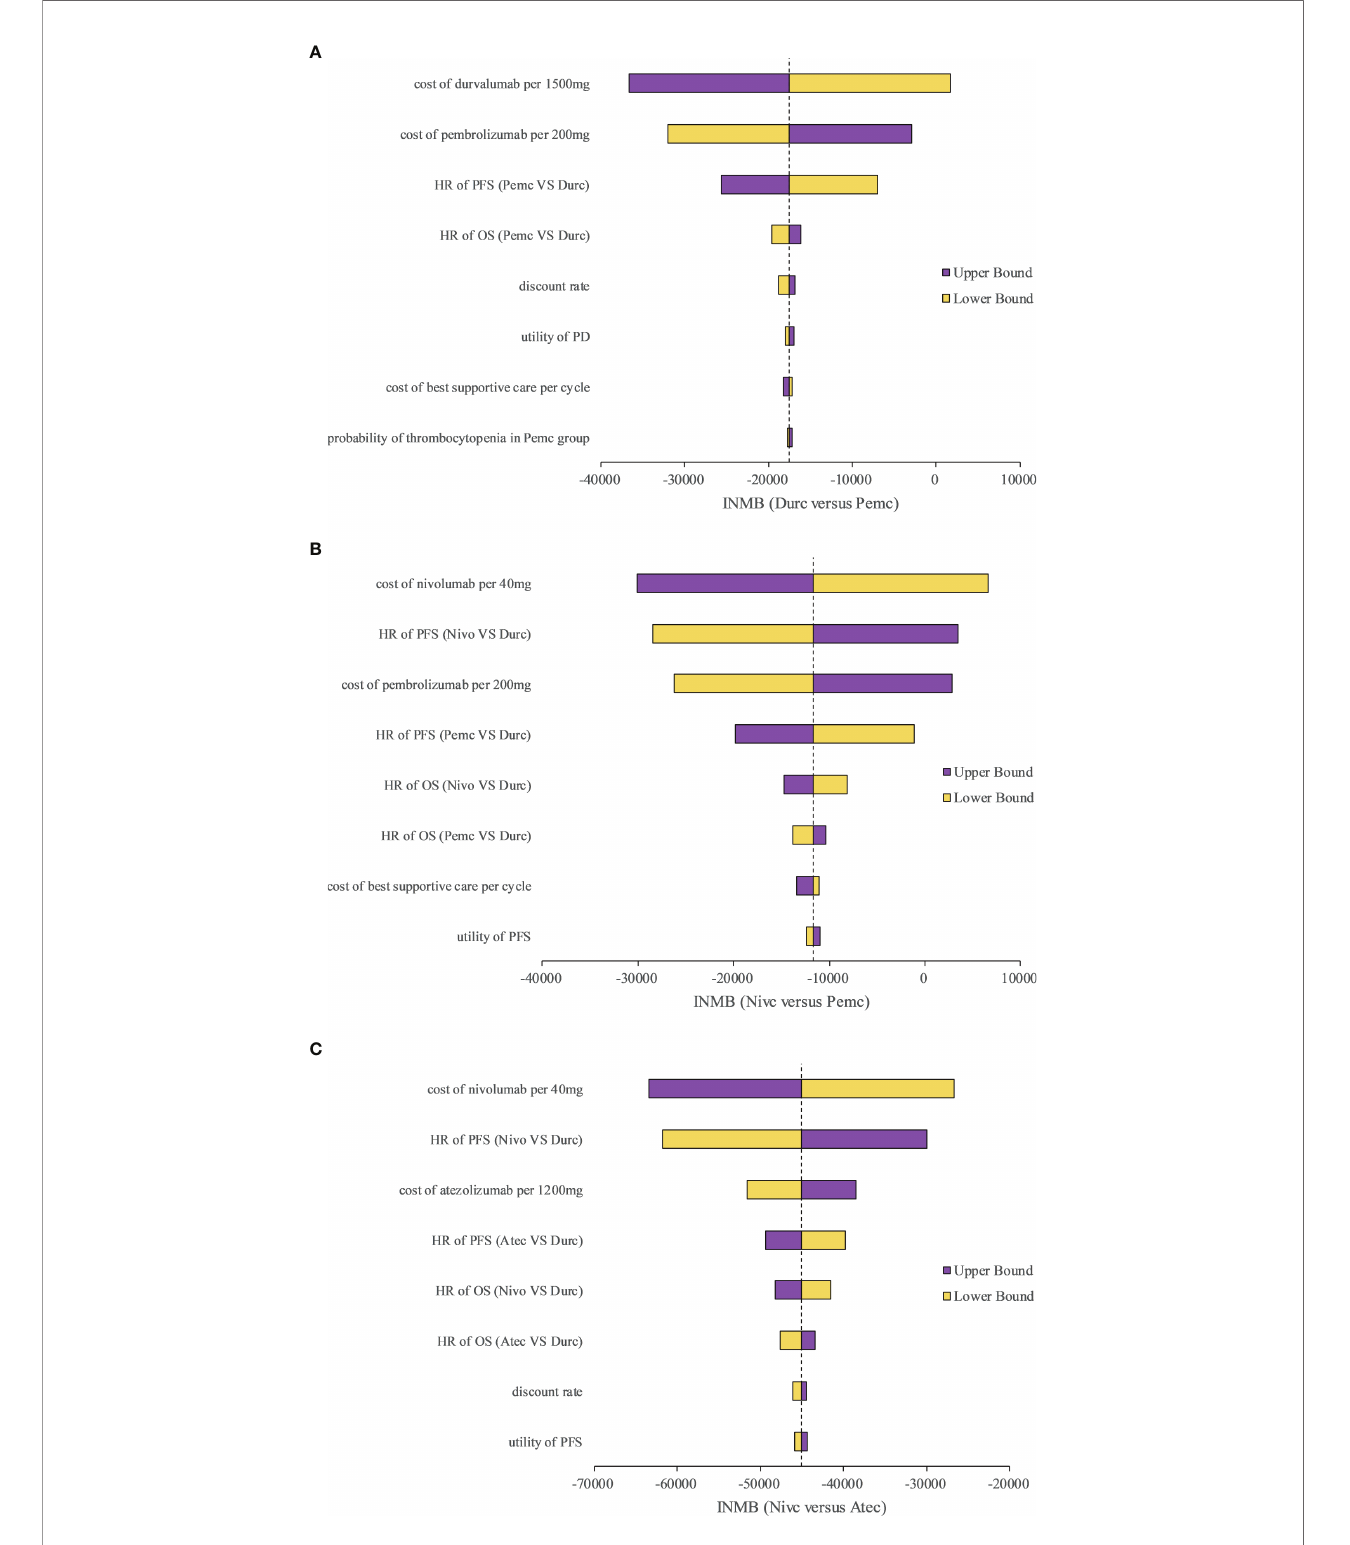
FIGURE 2 | Tornado diagram of one-way sensitivity analyses with greatest in fl uence parameters in (A) Durc versus Pemc, (B) Nivc versus Pemc and (C) Nivc versus Atec. Durc, durvalumab plus chemotherapy; Nivc, nivolumab plus chemotherapy; Pemc, pembrolizumab plus chemotherapy; Atec, atezolizumab plus chemotherapy; HR, hazard ratio; INMB, incremental net-monetary bene fi t; PFS, progression-free survival; PD, progressed disease; OS, overall